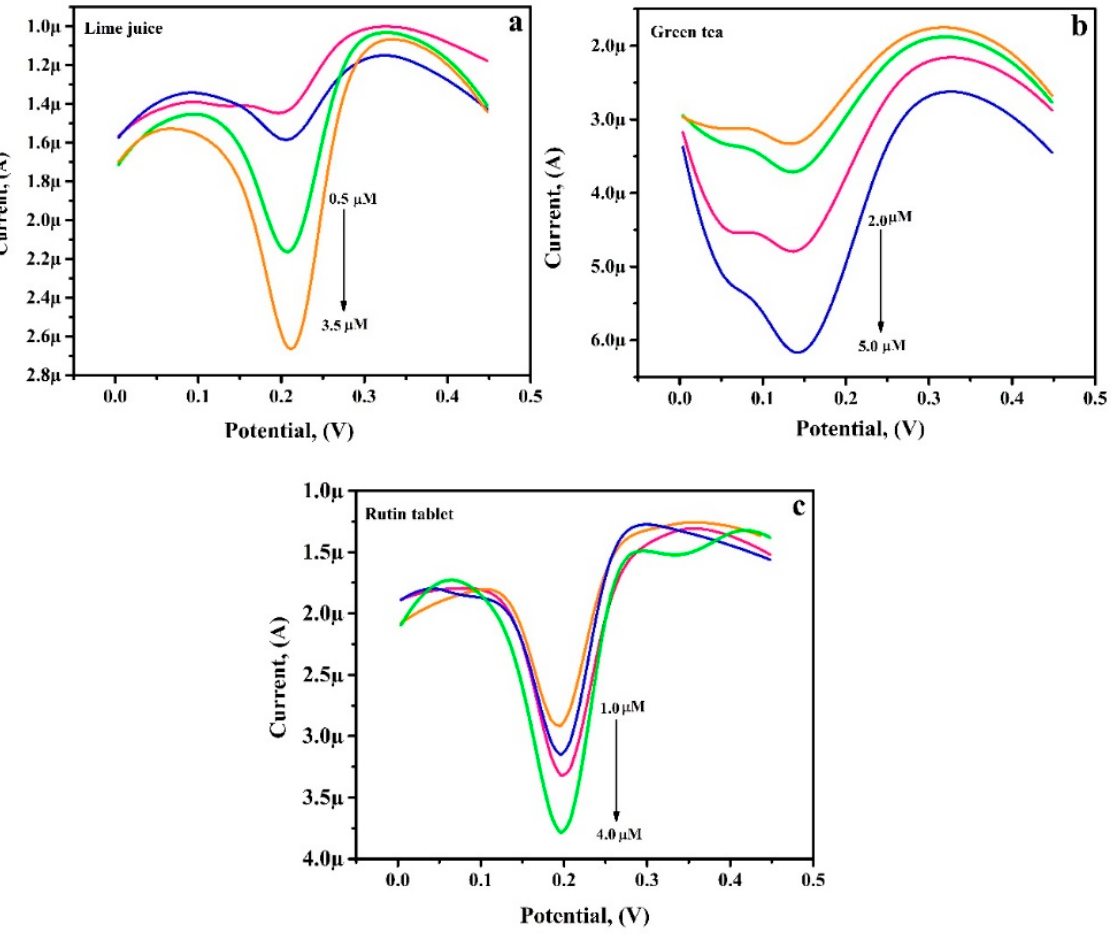
Figure 11. DPVs for RU detection in ( a ) lime juice, ( b ) green tea, and ( c ) tablet samples at PGAMGPE.